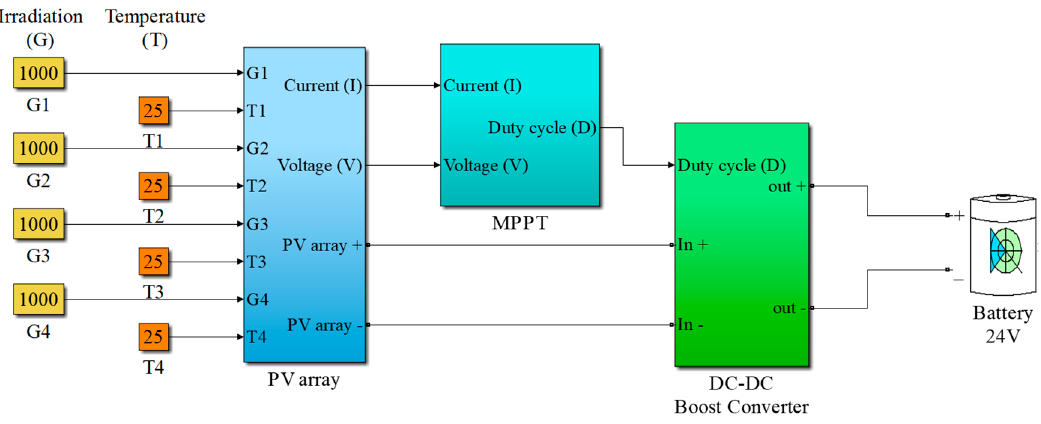
Figure 11. System blocks for simulation.